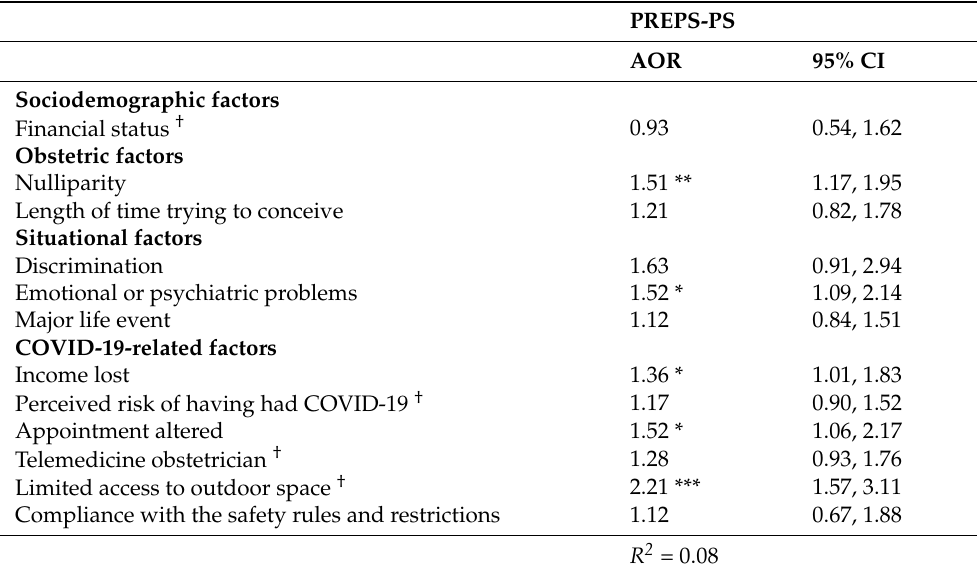
Table 4. Binary multivariate logistic regression predicting high levels of Preparedness Stress ( N =